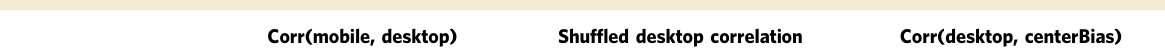
Table 1 Correlations between mobile and desktop gaze.